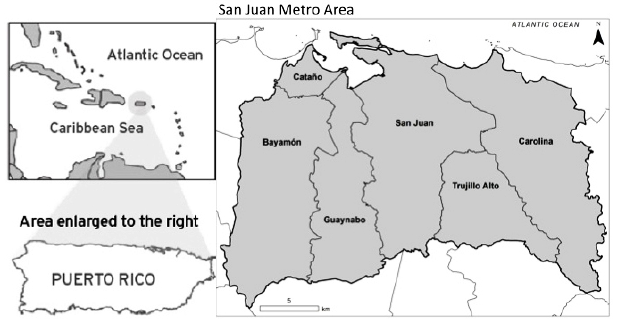
Fig. 1 . Map of Puerto Rico and the Caribbean (left panel), and the San Juan Metropolitan Area (SJMA) and the Municipality of San Juan (right panel). Source: Adapted from Ramos González et al.